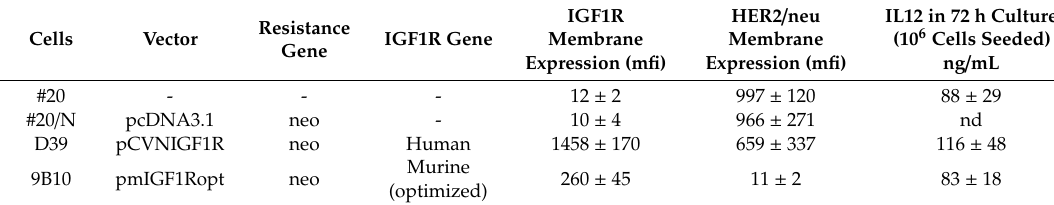
Table 1. IGF1R-expressing cells and control transfectants.